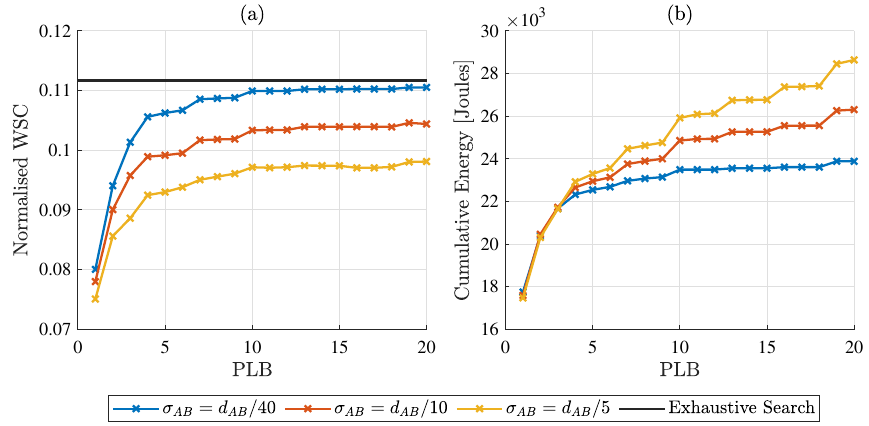
Fig. 6 a Normalised WSC mean values obtained over time, and b cumulative energy consumed in kilo‑Joules by all the UAVs over time. Both measured over PLBs with varying uncertainty of the distance between A and B σ AB , compared to the exhaustive search results